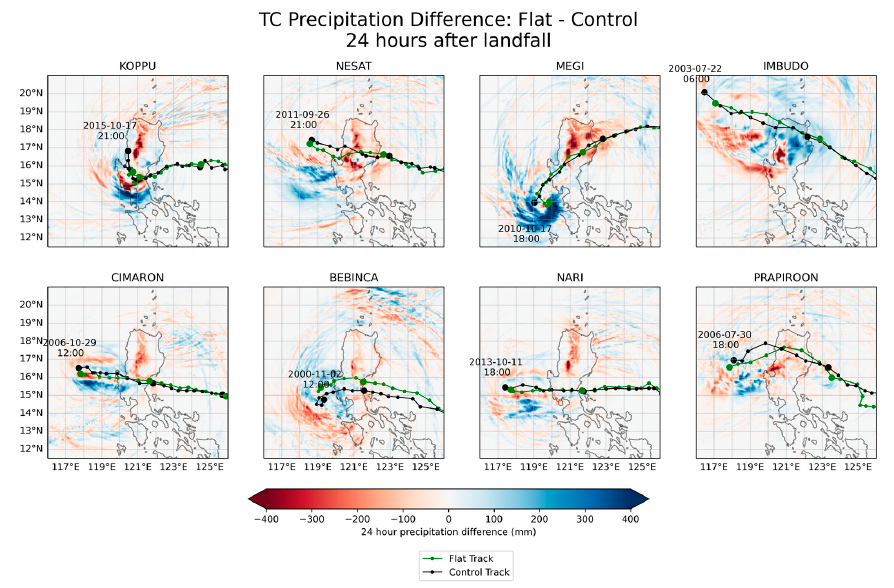
Figure 7. Difference in 24 h accumulated precipitation after landfall (shading) between Flat and Control. Three-hourly TC tracks for Flat and Control are coloured in green and black, respectively. Tracks are plotted up to 24 h after landfall, with each 24 h period plotted in larger markers, with the final points in both model tracks corresponding to the same time and date as labelled.